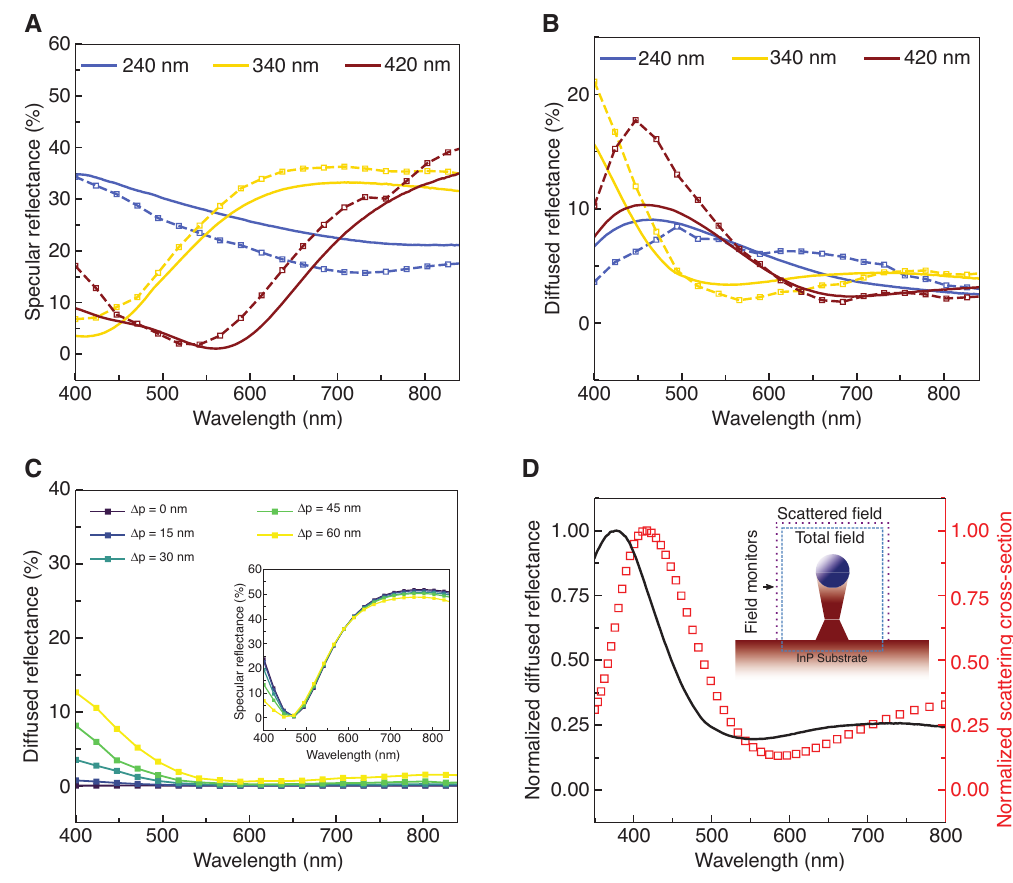
Figure 3: Specular and diffused spectral characteristics of DNPAs. The comparison of (A) the specular and (B) the diffused reflectances obtained from the measurements (solid lines) and FDTD simulations (dashed lines) of the fabricated DNPA with different nanopillar heights. (C) The simulated diffused reflectances for different extents of spatial disorder (∆p) in the nanopillar arrangement; the pillar height is 340 nm. Inset: The change in the specular component. (D) The normalized diffused reflectance (measured) for a DNPA sample and scattering cross-section (simulated) of a single pillar. The pillar height is 340 nm. Inset: The scattering cross- section was calculated using field monitors (dashed line) placed outside the TFSF source (solid line) and above the InP